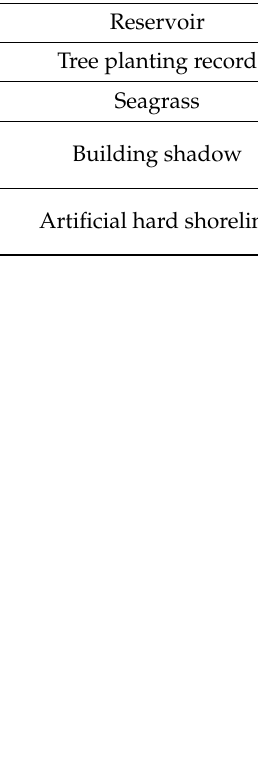
Table 3. Habitat classification scheme and definitions adopted in this